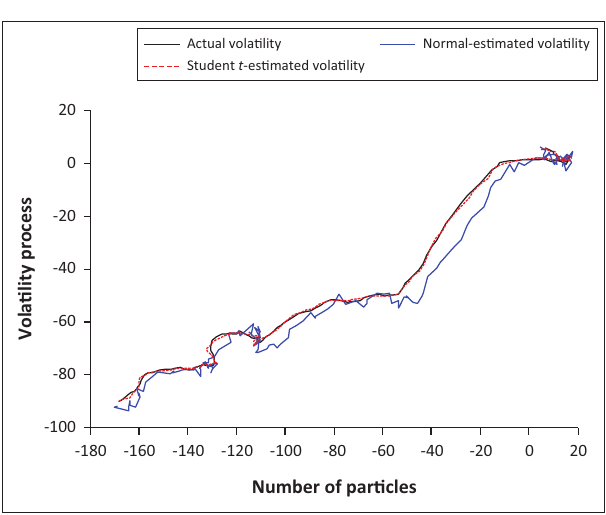
FIGURE 9: Brownian path for GlaxoSmith.